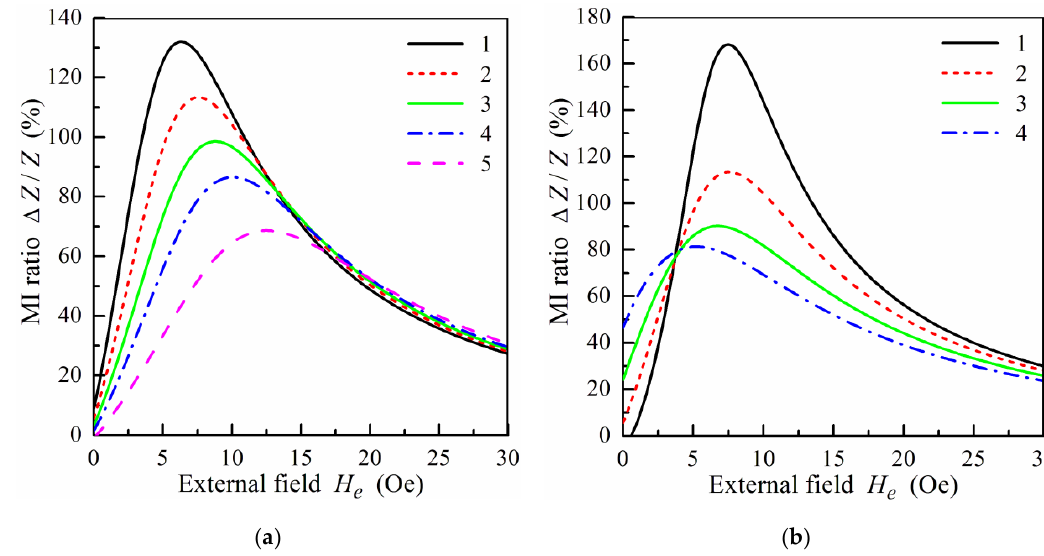
= 500 nm, d = 3 nm, 0 1 = = 5 10 17 s − 1 , = 0 1 2